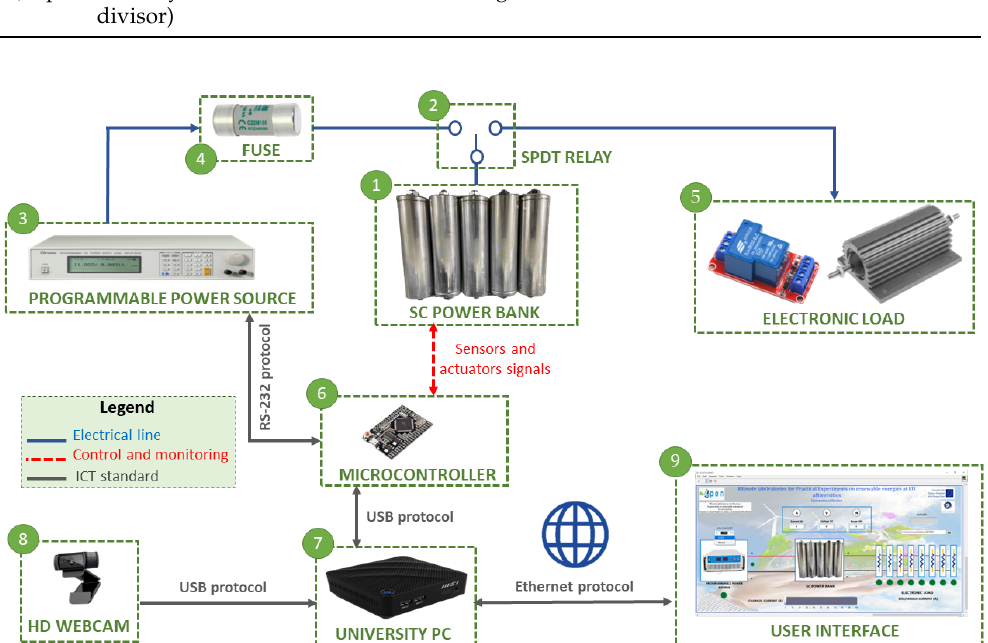
Figure 6. Supercapacitor remote laboratory. Component layout.